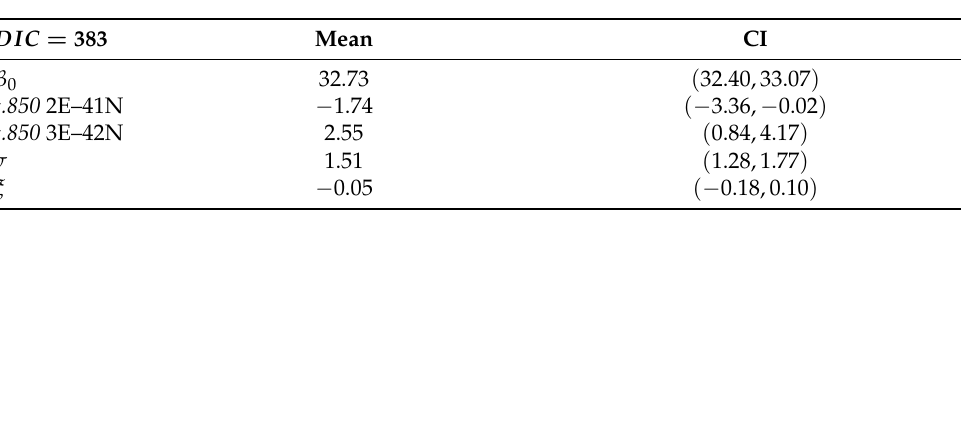
Table 5. Posterior mean and 95% CI of the final GEV model parameters according to the GEV-SSVS selection. Barcelona